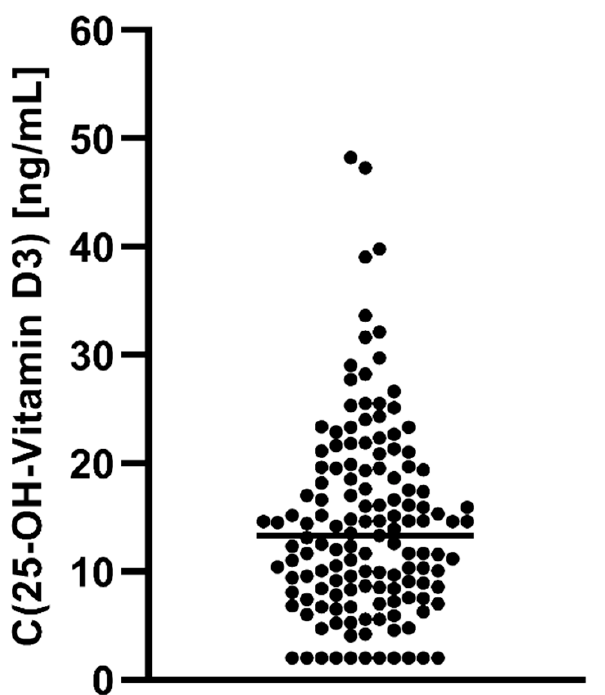
Figure 1. Distribution of 25-OH vitamin D-levels in our sample. Note the high proportions of patients following below the threshold of vitamin D insufficiency ( ≤ 20 ng/mL) and deficiency ( ≤ 10 ng/mL).